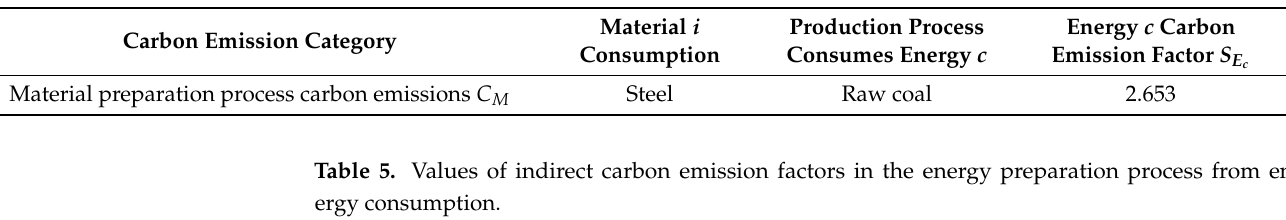
Table 4. Values of carbon emission factors in the material preparation process.